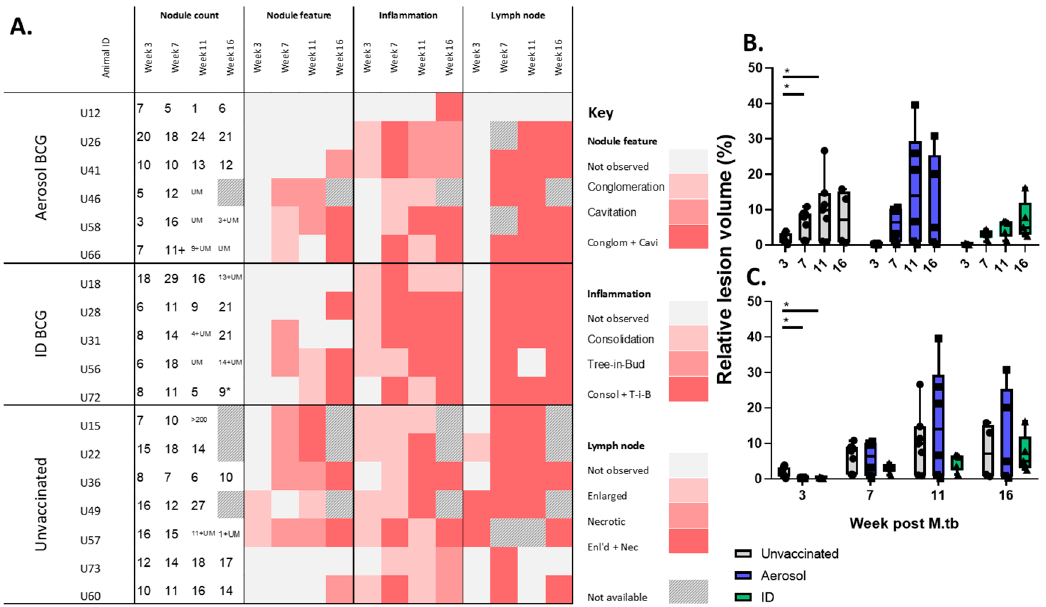
Figure 3. Development of thoracic pathology measured by computed tomography (CT) X-ray scanning at regular intervals following low dose aerosol challenge with M. tuberculosis . ( A ) Pulmonary nodule counts recorded from thoracic CT scans of individual animals at weeks 3, 7, 11 and 16 following aerosol challenge with M. tuberculosis are shown; UM = unmeasurable due to lesion conglomeration and lung lobe consolidation. Colour gradients in heat map plots represent the presence or absence of typical pulmonary features of tuberculous disease, including nodule conglomeration and cavitation, consolidation and tree-in-bud morphology due to pulmonary inflammation, and lymph node enlargement or necrosis. ( B , C ) Relative volume of tuberculous lung lesions quantified by CT analysis. Data points show the percentage area of damaged lung tissue measured in individual animals, with group median, interquartile range and minimum and maximum values shown by box and whisker plots. Asterisks denote significant differences measured within (Wilcoxon, Figure B) and between treatment groups (Mann–Whitney, Figure C), p ≤ 0.05.